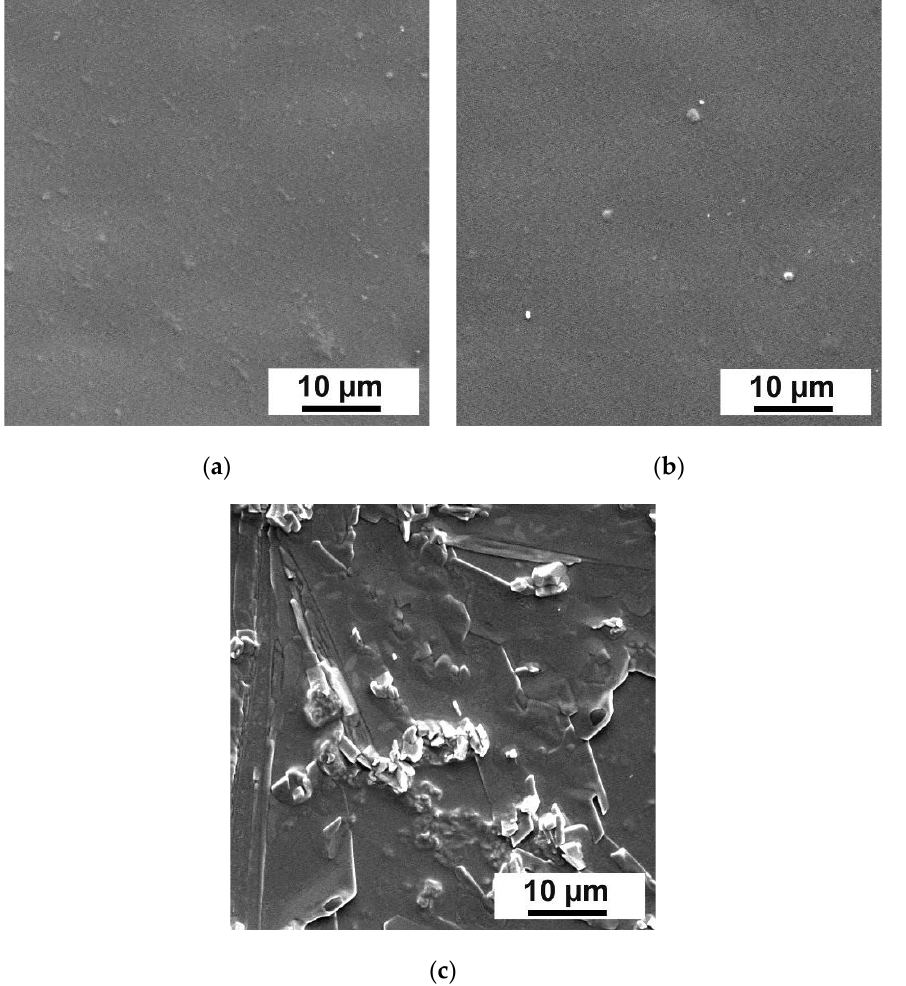
Figure 5. SEM microphotographs of selective layers of composite membranes ChS-Fe-BTC/PAN obtained by physical adsorption: ( a ) P3, ( b ) P3-5, ( c ) P3-20.